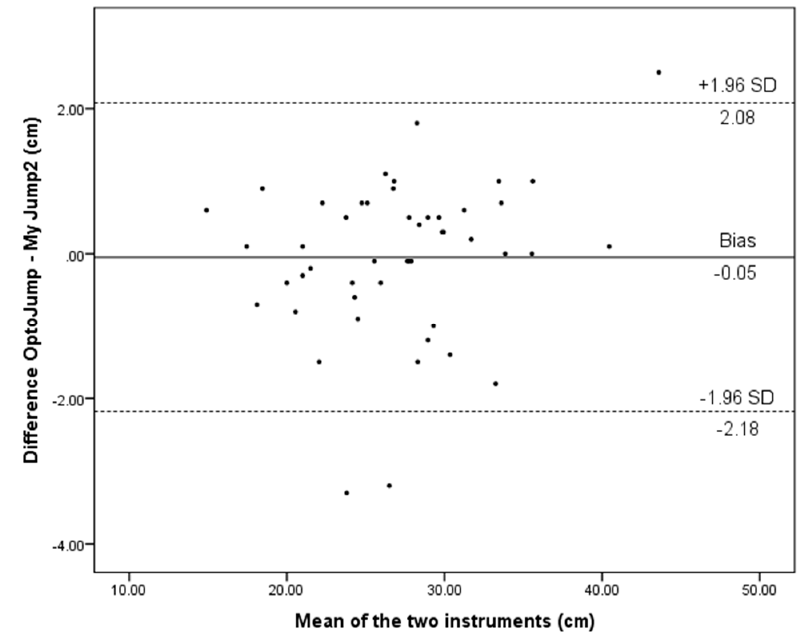
Figure 4. Level of agreement (Bland–Altman) with 95% limits of agreement (dashed lines) and the mean di ff erence (solid line) between My Jump 2 and the OptoJump for CMJAM in the whole